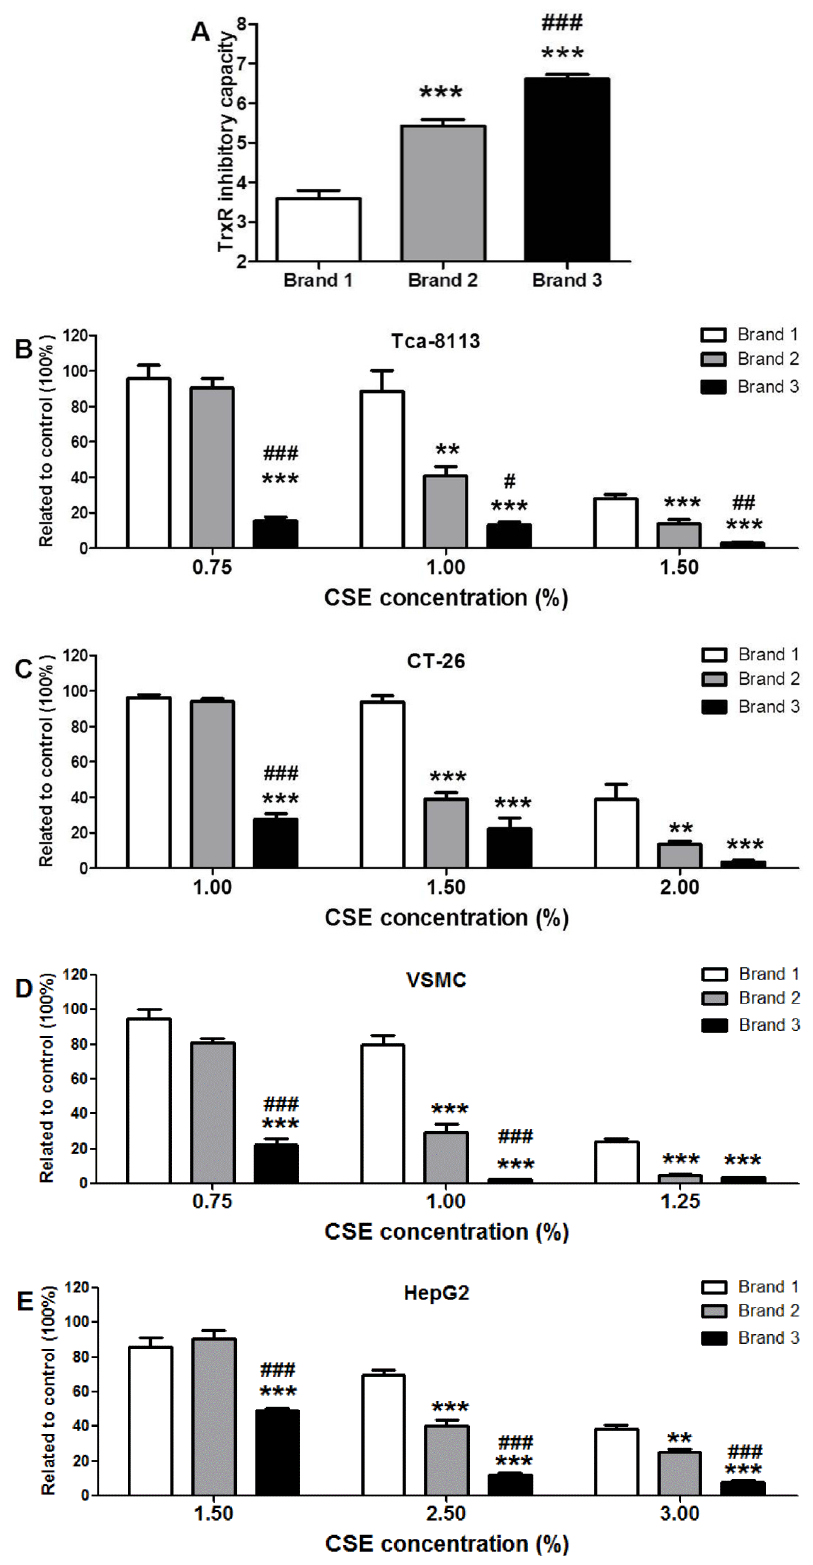
Figure 5. Cytotoxic evaluations of cigarette smoke extracts (CSEs) with different thioredoxin reductase (TrxR) inhibitory capacities; ( A ) TrxR inhibitory capacity of CSEs prepared from 3 commercial brands; ( B – E ) cell viability of indicated cell lines. Data are presented as means ± SEM ( n = 6). Compared to Brand 1, ** p < 0.01; *** p < 0.001. Compared to Brand 2, # p < 0.05; ## p < 0.01; ### p < 0.001.